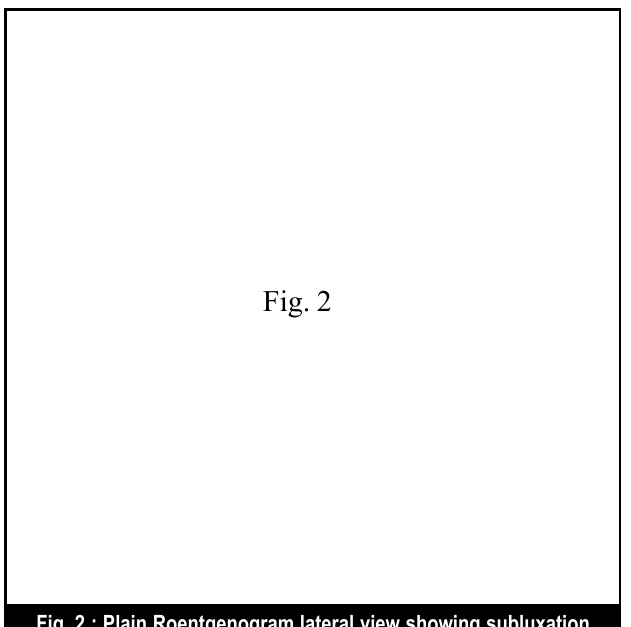
Fig. 2 : Plain Roentgenogram lateral view showing subluxation of C5 over C6 causing angular deformity of more than 11 0